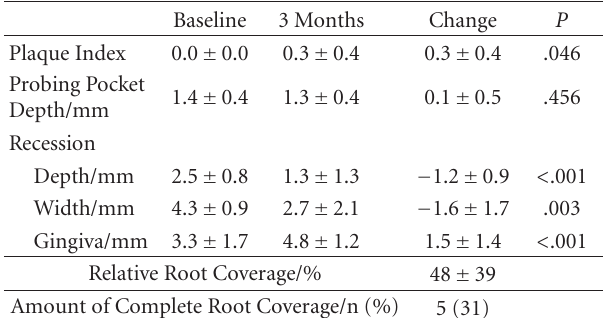
Table 4: Satisfaction with treatment